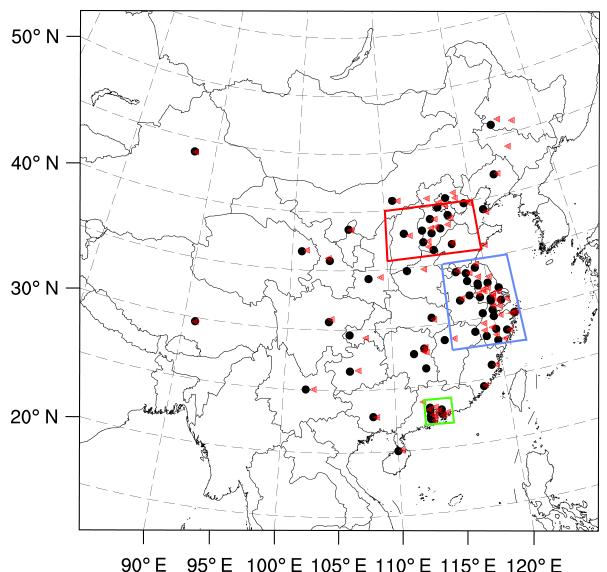
Figure 1. Locations of 77 PM 2 . 5 assimilation observation stations (black dot) and the 77 independent observation stations (red tri- angle) in the model domain. The three coloured boxes mark sub- regions with relatively dense coverage for the Beijing–Tianjin– Hebei region (JJJ; 12 assimilation stations and 12 independent sta- tions; red box), the Yangtze River delta (YRD; 24 assimilation sta- tions and 24 independent stations; blue box) and the Pearl River delta (PRD; 9 assimilation stations and 9 independent stations; green